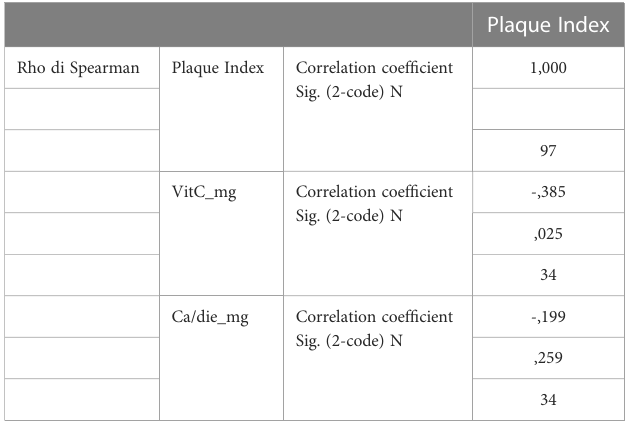
TABLE 11 Spearman ’ s correlation, evaluation of the correlations between the plaque index and nutrient intake (calcium, carbohydrates and Vit C). Rho di